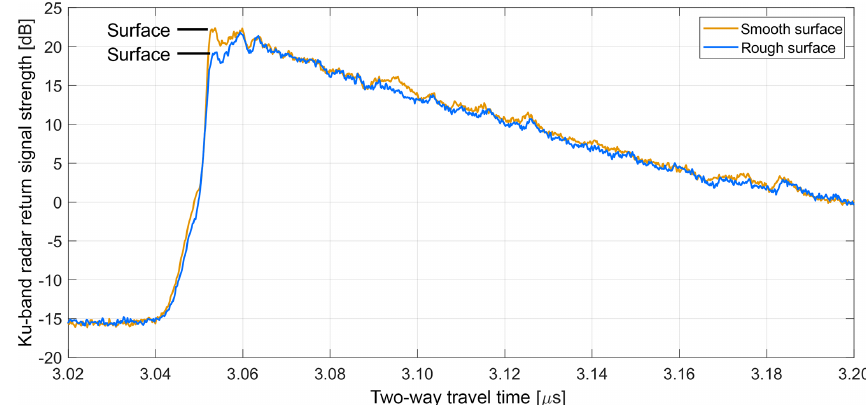
Figure A4. Relative Ku-band radar return signal strength over smooth and rough surfaces. A total of 100 traces were stacked for the averaged waveforms. For location see Fig. 9. The difference between the radar waveforms indicates that radar altimeters are potentially prone to elevation errors when threshold or leading edge trackers are being used for range